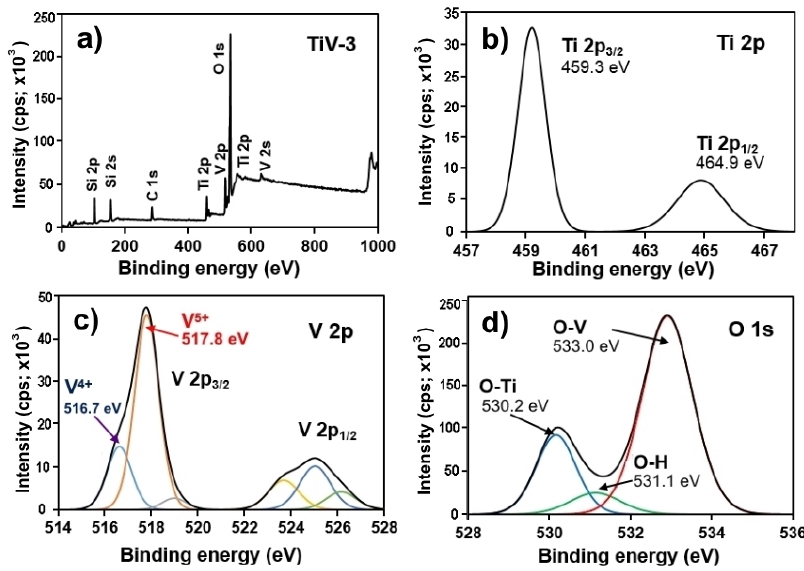
Figure 3. Spectrum of X-ray photoelectron spectroscopy for the ( a ) survey scan, and ( b – d ) high-resolution XPS spectra of the TiV-3 sample.